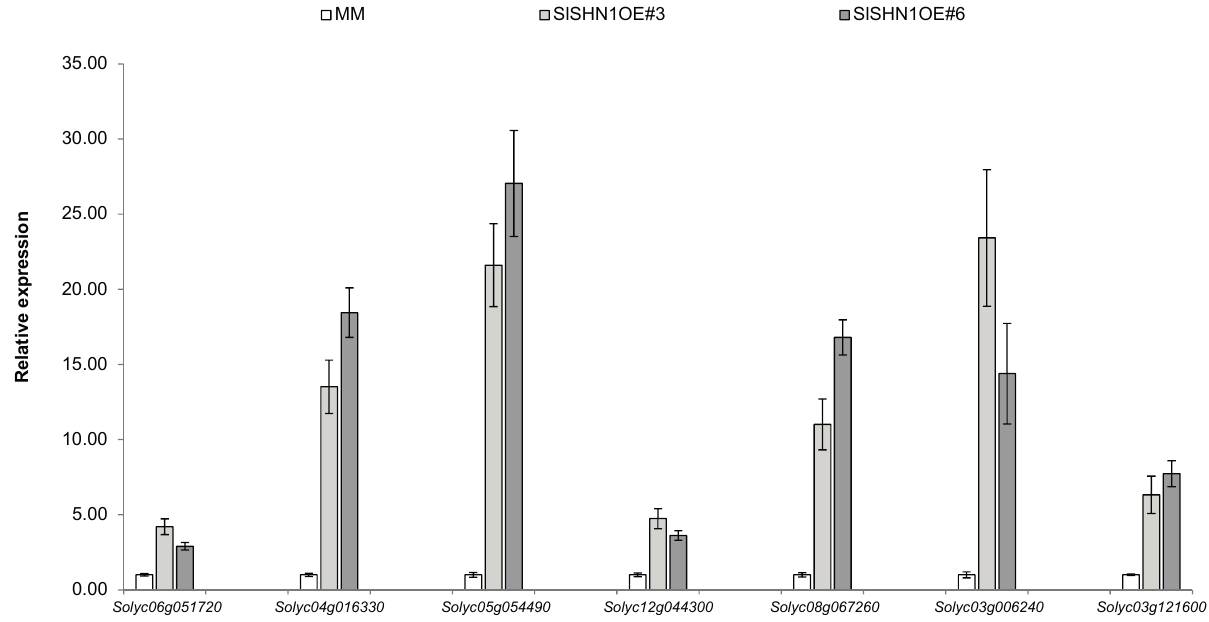
Figure 5. Gene expression analysis of seven cutin-related synthesis genes ( Solyc06g051720 (GDSL-motif lipase), Solyc04g016330 (GDSL-motif lipase), Solyc05g054490 (Enoyl-CoA reductase), Solyc12g044300 (acyl-CoA synthase), Solyc08g067260 (Fiddlehead), Solyc03g006240 (HOTHEAD-like) and Solyc03g121600 (HOTHEAD-like)) in leaves of transgenic line over-expressing SlSHN1 (SlSHN1OE#3 and SlSHN1OE#6) and wild type plants (MM). The bars are standard deviations (SD) of three technical